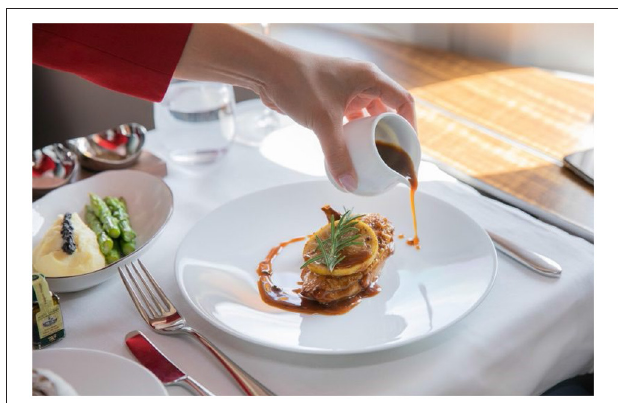
FIGURE 2 | Staging and performing the meal; visual extract; airline#2.